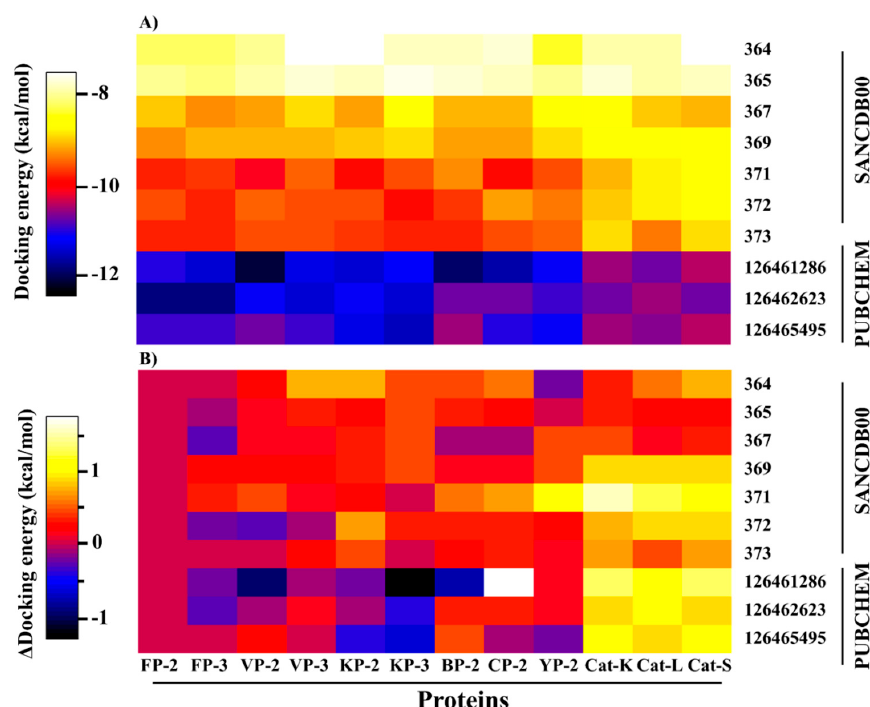
Figure 4. A heatmap representation of ( A ) interaction energies between the selected hits and the plasmodial proteases as well as human cathepsins and ( B ) interaction energy difference of the various complexes to the corresponding FP-2-hit complex. Weak interactions are shown in white while in black are complexes with the strongest affinities.